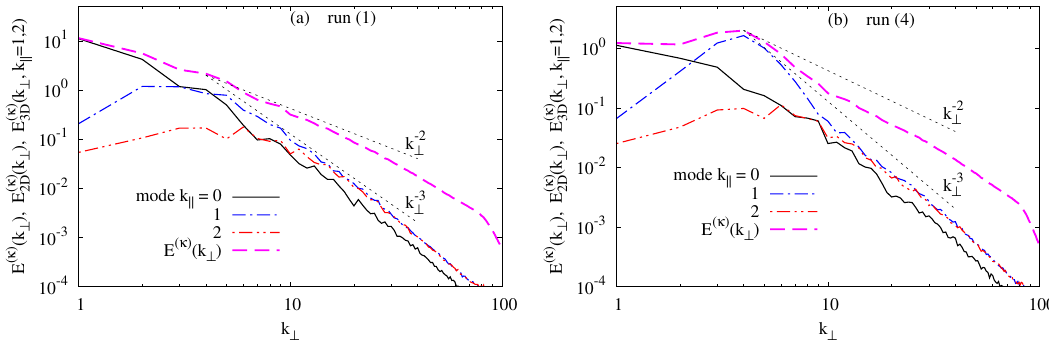
( κ ) ( k ⊥ ) and E ( κ ) ( k ⊥ , k = 1,2 ) (cid:107) 2 D 3 D